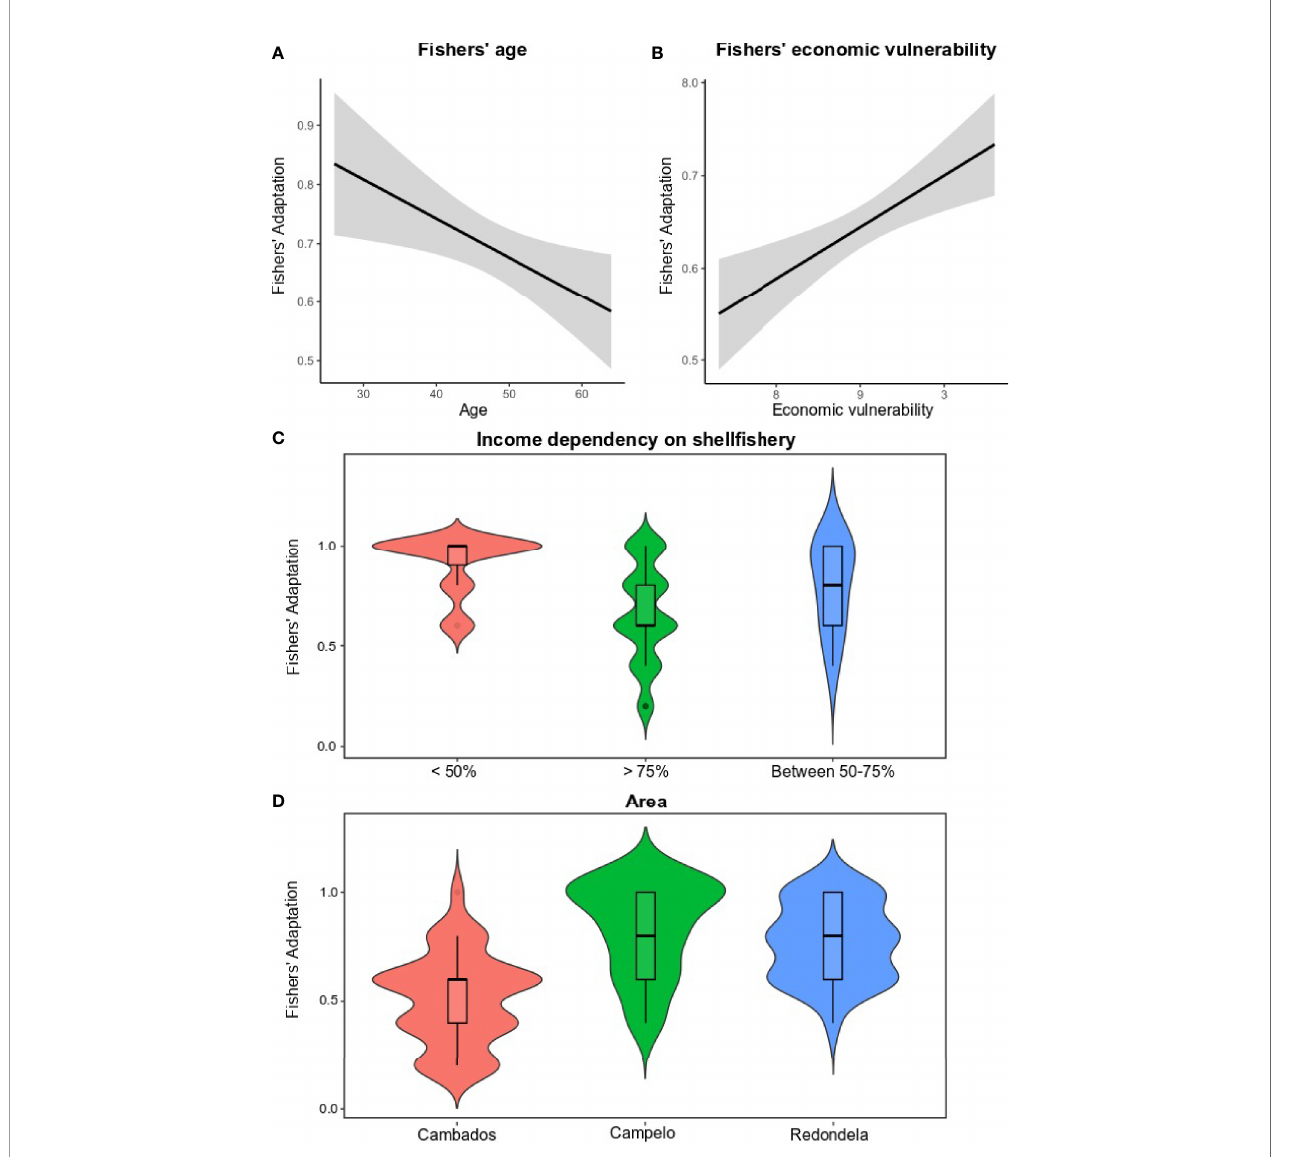
FIGURE 6 | Predictor effect of the variables from the averaged model to the fi shers ’ adaptation to regime shifts: (A) fi shers ’ age, (B) fi shers ’ economic vulnerability, (C) dependency on income from shell fi shing, and (D) area (area where fi shing takes